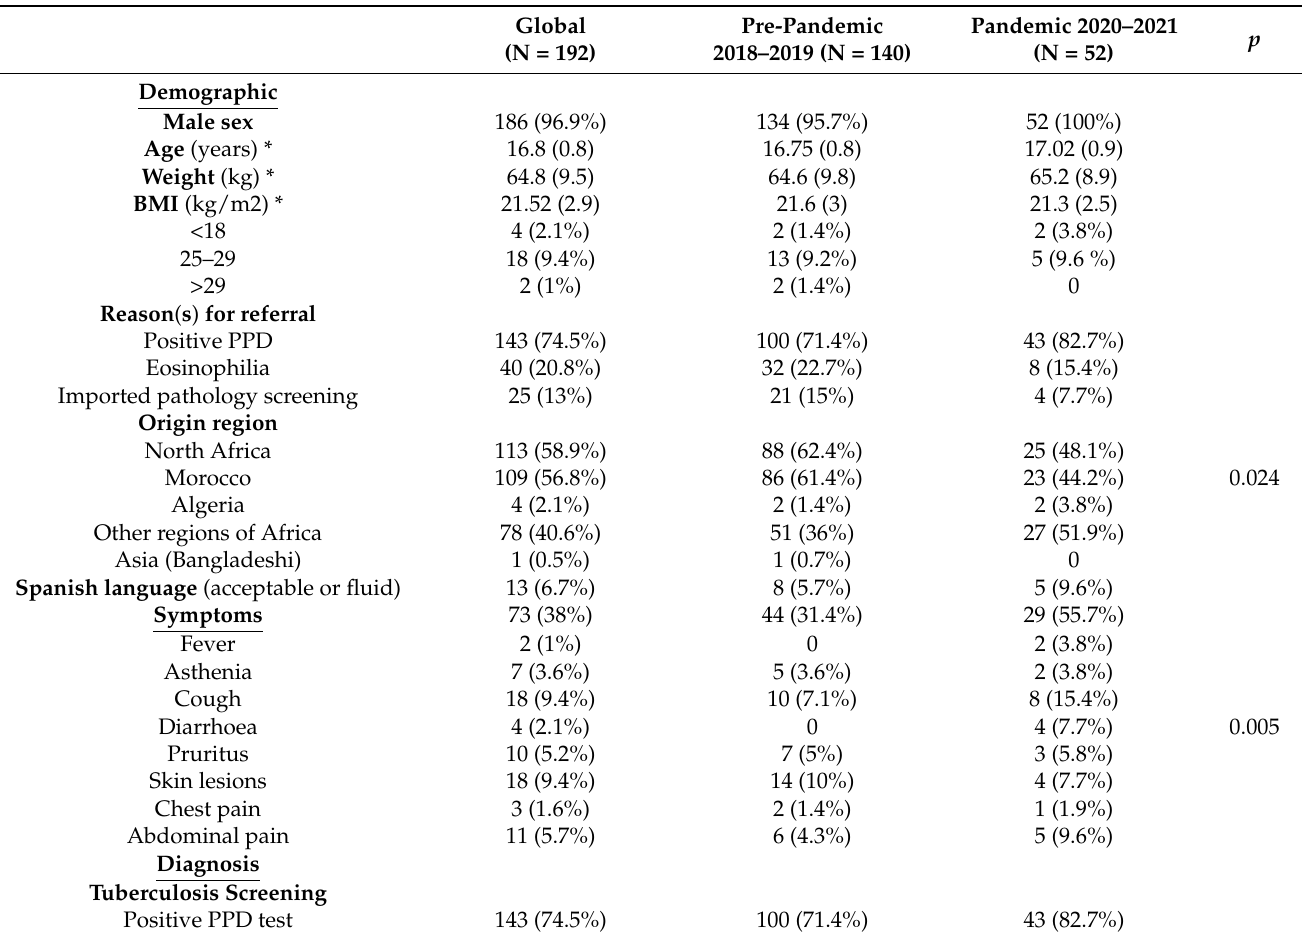
Table 1. Global descriptive, pre-pandemic years (2018–2019) and pandemic years (2020–2021). Global (N = 192)